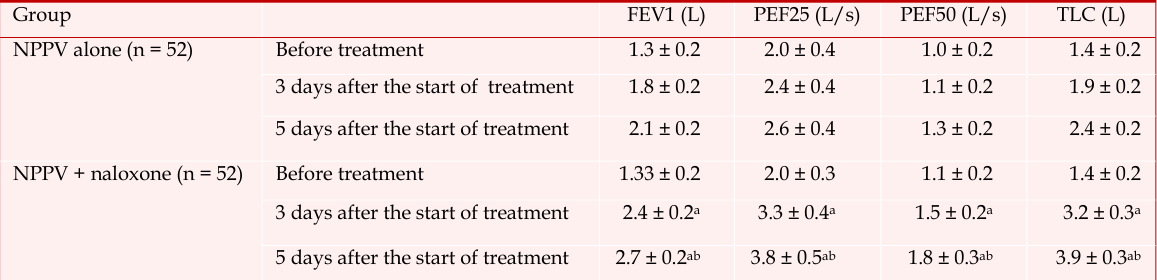
Pulmonary function measurements before and after treatment with NPPV or NPPV plus naloxone Group